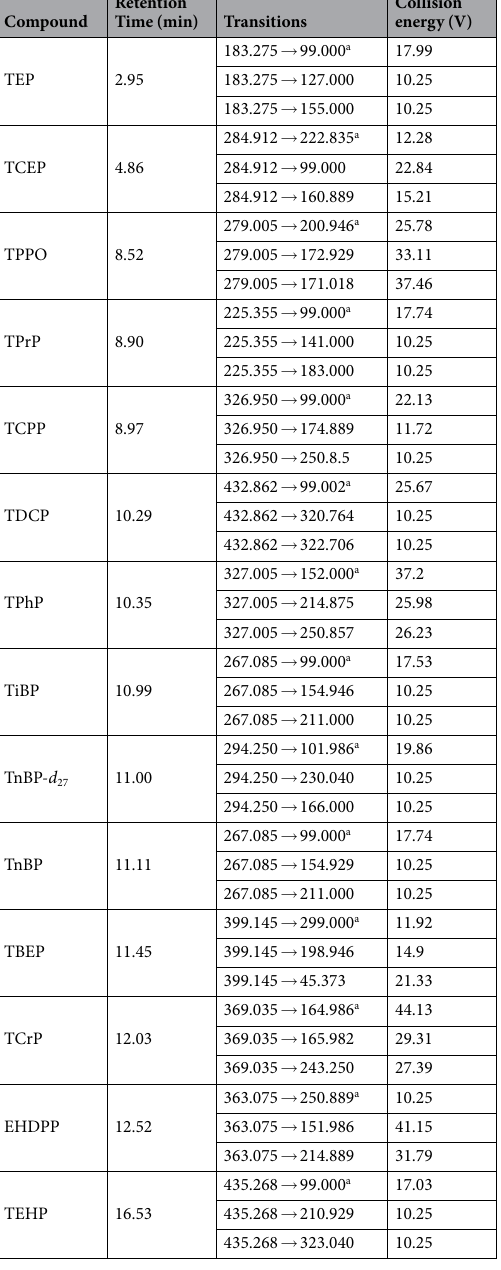
Table 4. The UHPLC-ESI + -MS/MS detection parameters. a Transitions for